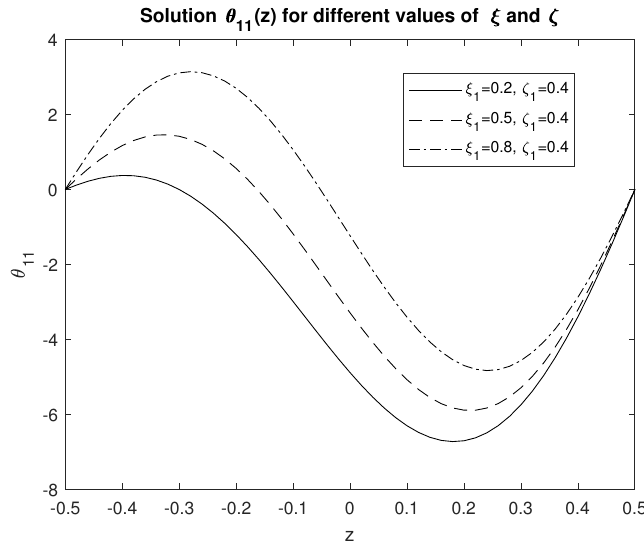
Figure 3. Solutions θ 11 ( z ) for positive ξ 1 .